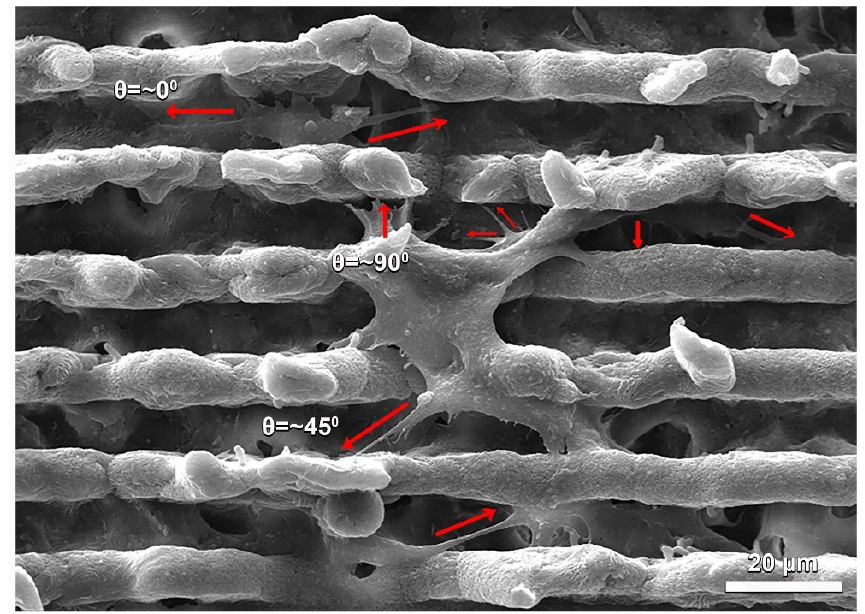
Figure 6. Representative SEM image demonstrating the orientation of human osteoblast cells with respect to groove direction on the first day of culture on a PH-2 membrane. Similar cell orientation was observed on different materials (P, PH, PHG) and pattern types (1 and 2) (Supplementary Figure S2). SEM images of P, PH, PHG membranes cultured with hOBs on the seventh day of